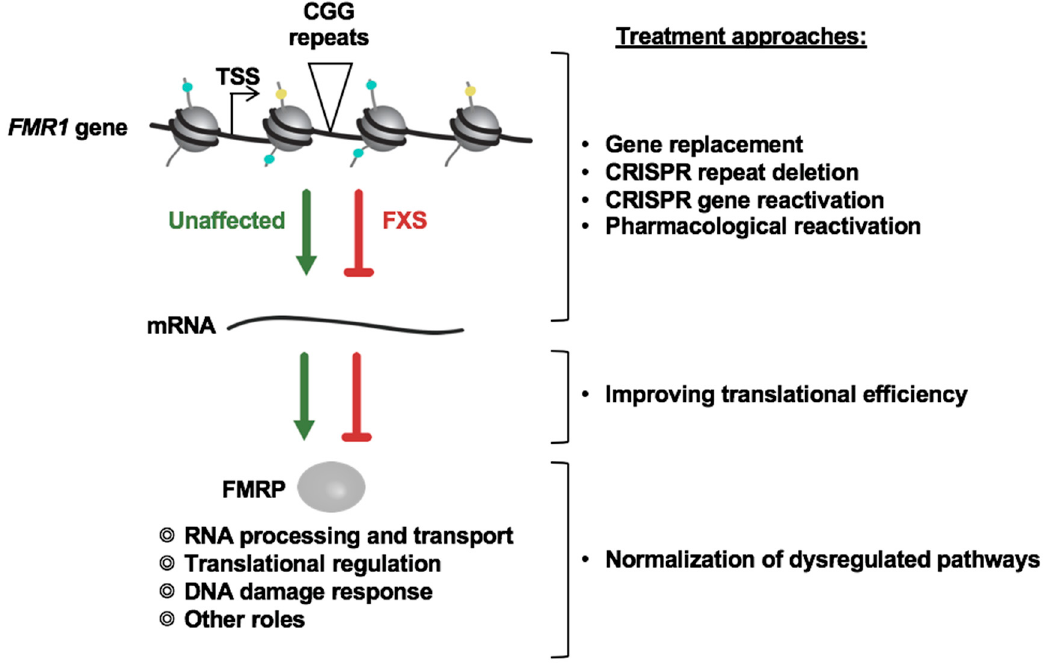
Figure 1. Possible treatment approaches for fragile X syndrome (FXS).